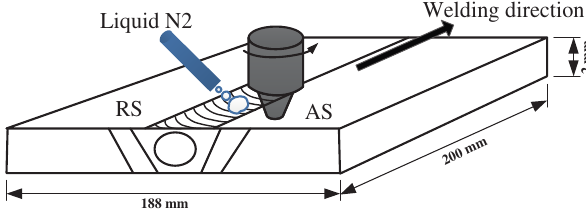
Figure 1: Schematics of the TIC aided FSW.